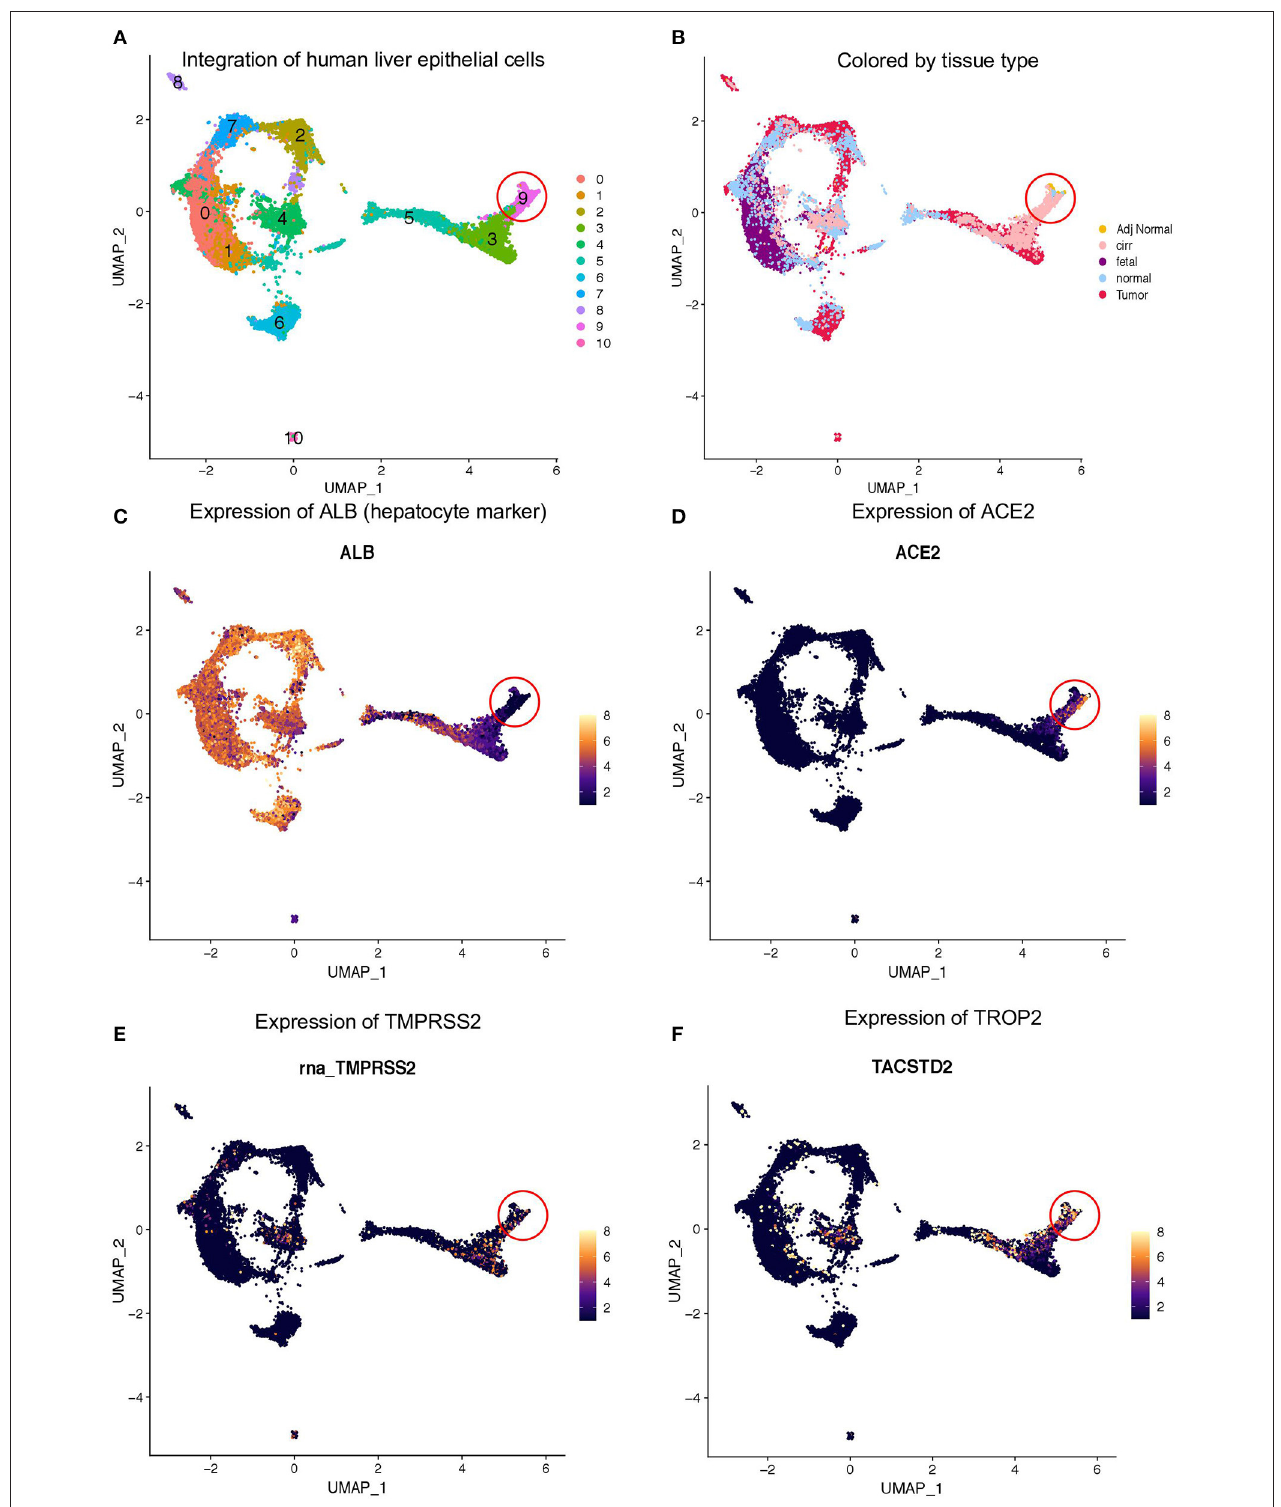
FIGURE 2 | Expression of ACE2 and TMPRSS2 in liver epithelial cells. (A) Sub-clustering of epithelial cells from fetal, adult normal, cirrhotic, and HCC patients, which identified 11 clusters in the human liver. (B) Louvain clusters, colored by tissue types. Expression of (C) ALB, (D) ACE2, (E) TMPRSS2, and (F) TROP2.